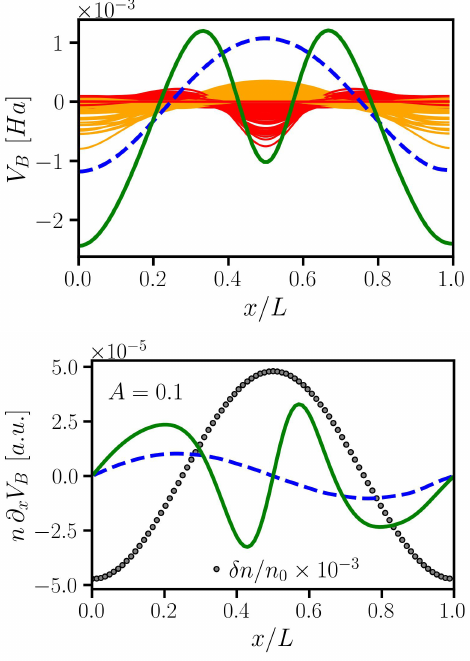
Figure 8: The same as in Fig. 7, but for q = 0.3 q